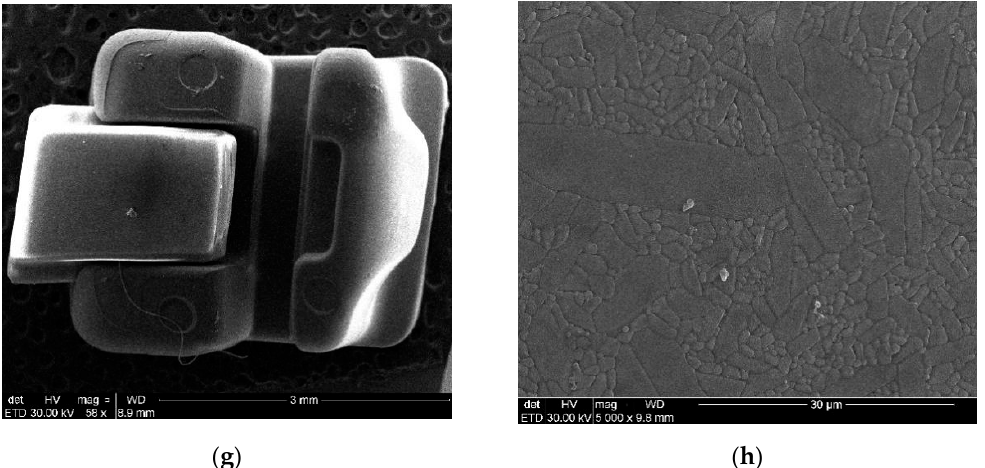
Figure 4. Scanning electron microscopy (SEM) images of stainless steel brackets: ( a,b ) conventional brackets; ( c,d ) stainless steel self-ligating brackets; ( e,f ) polycrystalline alumina conventional brackets; ( g,h ) polycrystalline alumina self-ligating brackets. ( a ) Magnification 100×, ( b )magnification 500× ( c ) magnification 100×, ( d ) magnification 500×, ( e ) magnification 65×, ( f ) magnification 20,000×, ( g ) magnification 58×, ( h ) magnification 5000×.